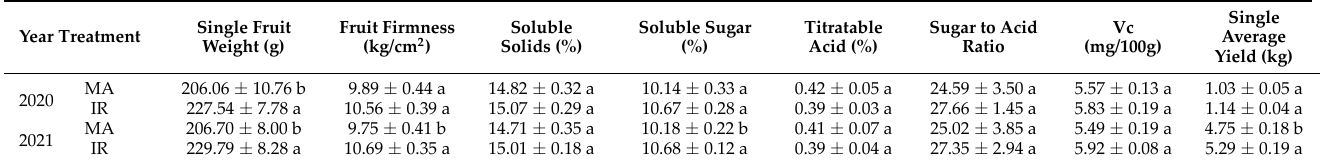
Table 2. The appearance and internal quality of the fruit in different planting